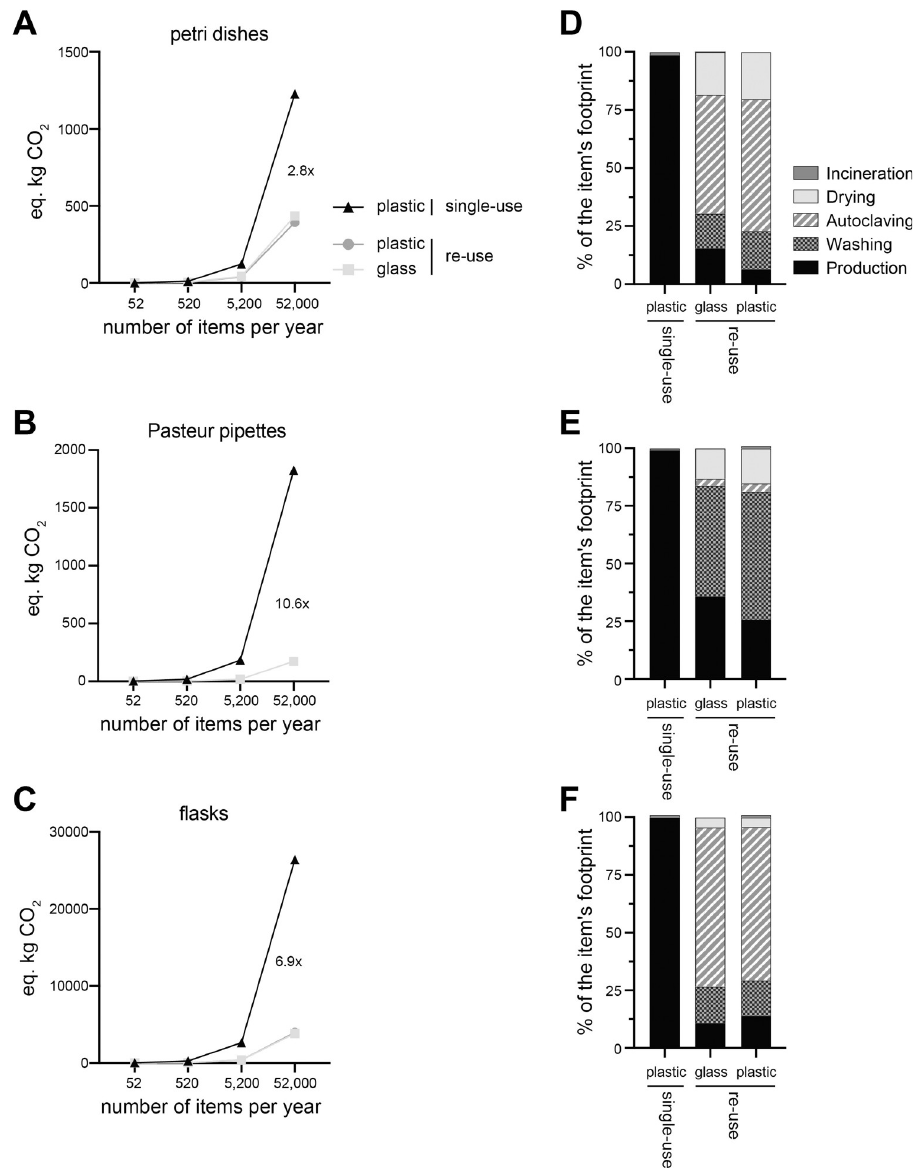
Fig 2. CO 2 equivalent footprint of petri dishes, Pasteur pipettes, and conical flasks. ( A-C ) CO 2 e resulting from the use of single-use plastic or re-use of plastic or glass 6cm petri dishes, Pasteur pipette and 1L conical flasks. The number of items used varied from 52 per year (1 item reused every week) to 52,000 per year (1000 items reused every week). ( D-F ) Percentage of CO 2 e per life cycle stages (production, washing, autoclaving, drying, and disposal) for the 3 scenarios in